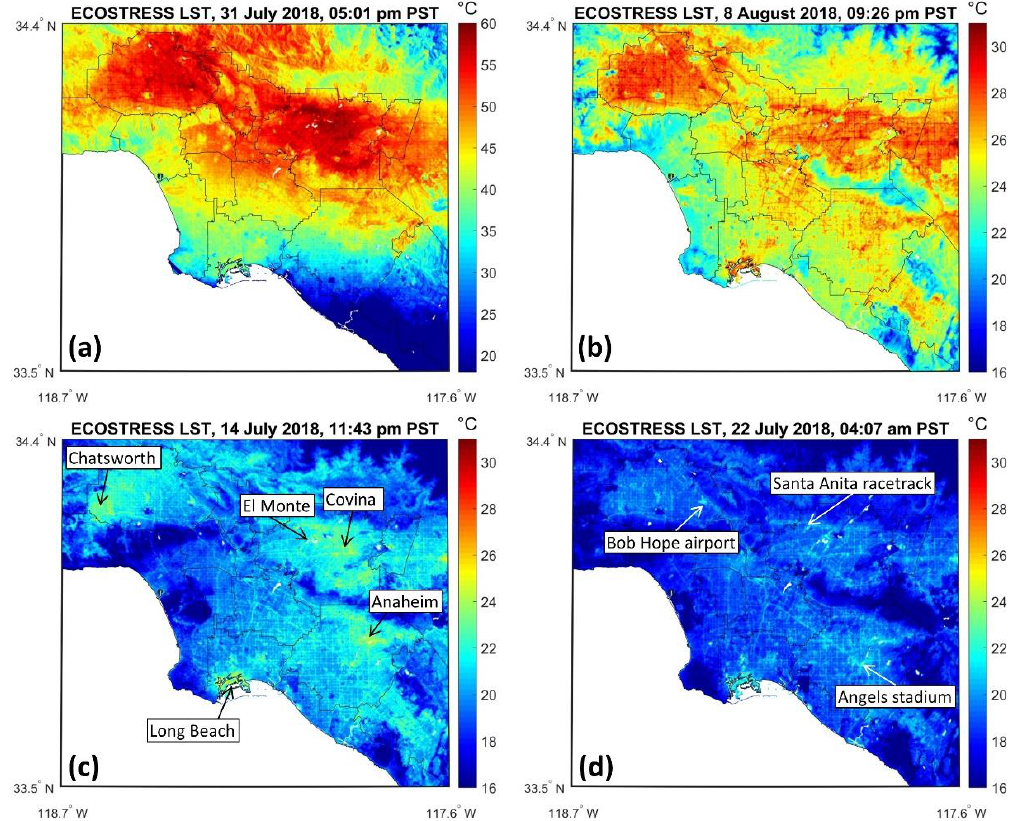
Figure 2. ECOSTRESS land surface temperature (LST) retrieved over the LA county study region on: ( a ) 31 July 2018, 05:01 pm; ( b ) 8 August 2018, 09:26 pm; ( c ) 14 July 2018, 11:43 pm, and; ( d ) 22 July 2018, 04:07 am. All times are Pacific Standard Time (PST). Ocean and inland waterbody pixels have been screened and appear as white pixels.